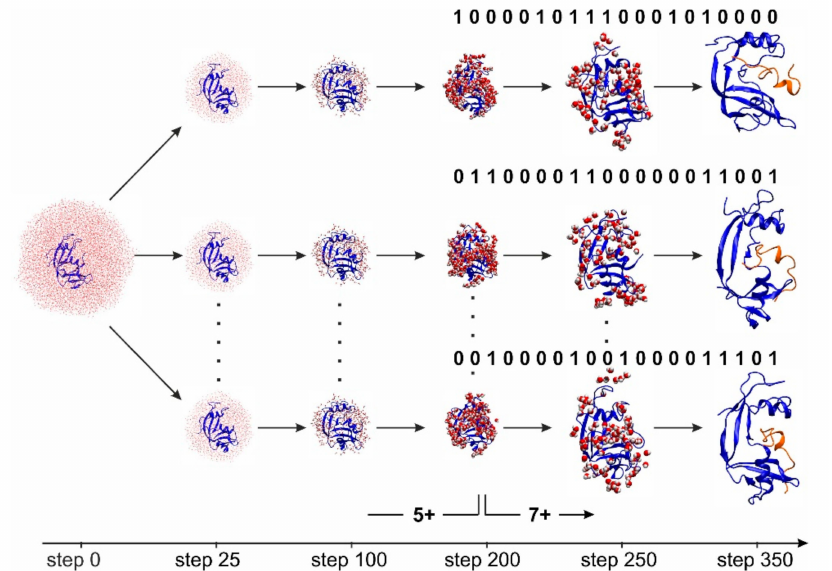
Figure 5. Snapshots of multiple-run-multiple-states-Arg (MMSA) simulations of the in-silico desolva- tion process of RNAse S. For each simulation with a total of 350 steps, each, a different proton location but an equal number of protons was set at step 200 of the simulation process to generate RNAse S ions with 7+ charge state patterns. 7+ charge state patterns were distributed over 20 protonatable sites as is indicated by the binary codes (1: occupied; 0: unoccupied). Solvent water molecules were removed after each step of the simulation by random selection (for details see text). The final RNAse S structures, three arbitrarily chosen structures are shown at the right, display subtle differences of amino acid residue positions, mostly affecting the S-peptide (red) which is kept bound to the S-protein